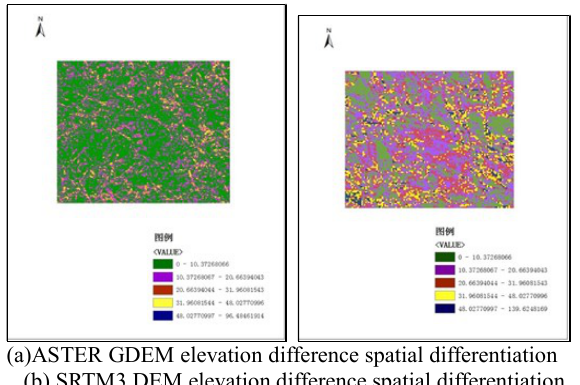
Figure 1 ASTER GDEM and WorldDEM data elevation difference spatial differentiation in test area A